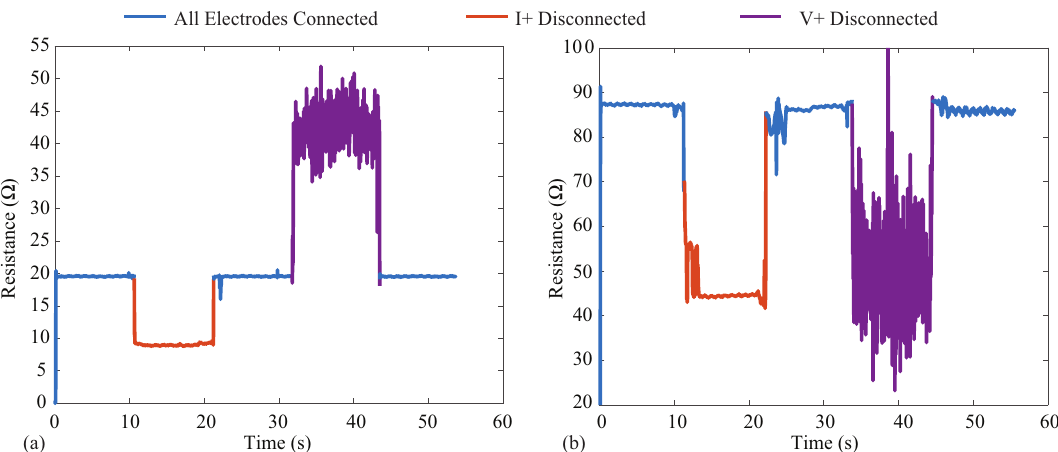
Figure 12. Resistance measurements at 128 kHz with current and voltage electrode disconnection events on the ( a ) testboard and ( b ) the bicep. The blue corresponds to times when all electrodes are connected, orange represents when the I+ current lead is disconnected, and purple represents when the V+ voltage lead is